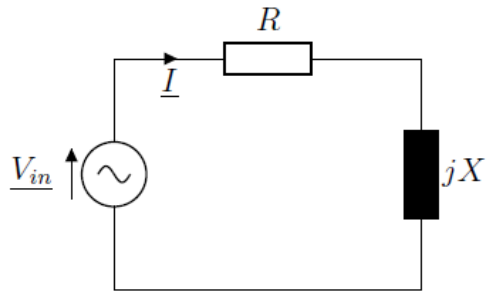
Figure 7. Electrical